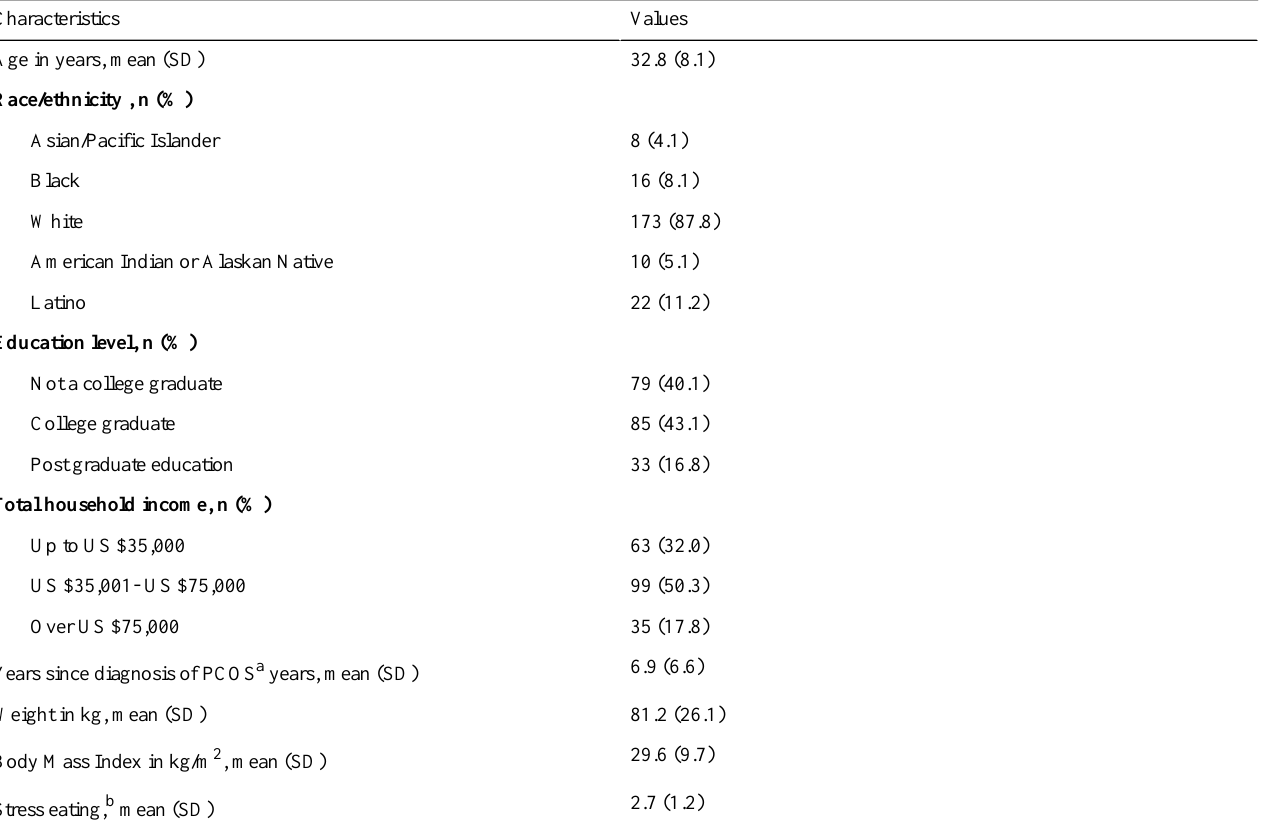
Table 1. Baseline characteristics of women with PCOS